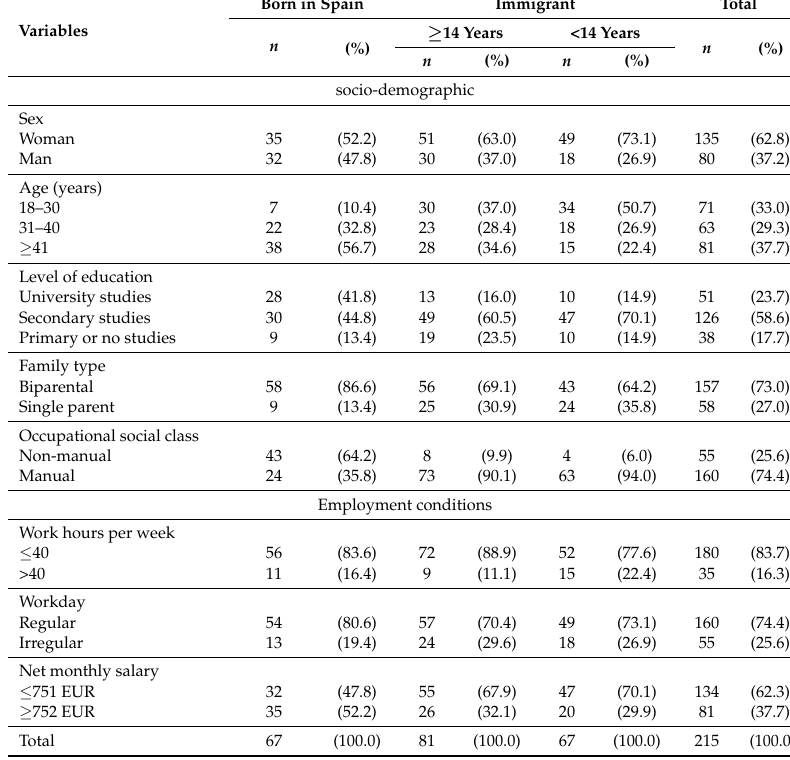
Table 1. Distribution of Workers Included in the Study by Socio-Demographic Characteristics and Employment Conditions by Migratory